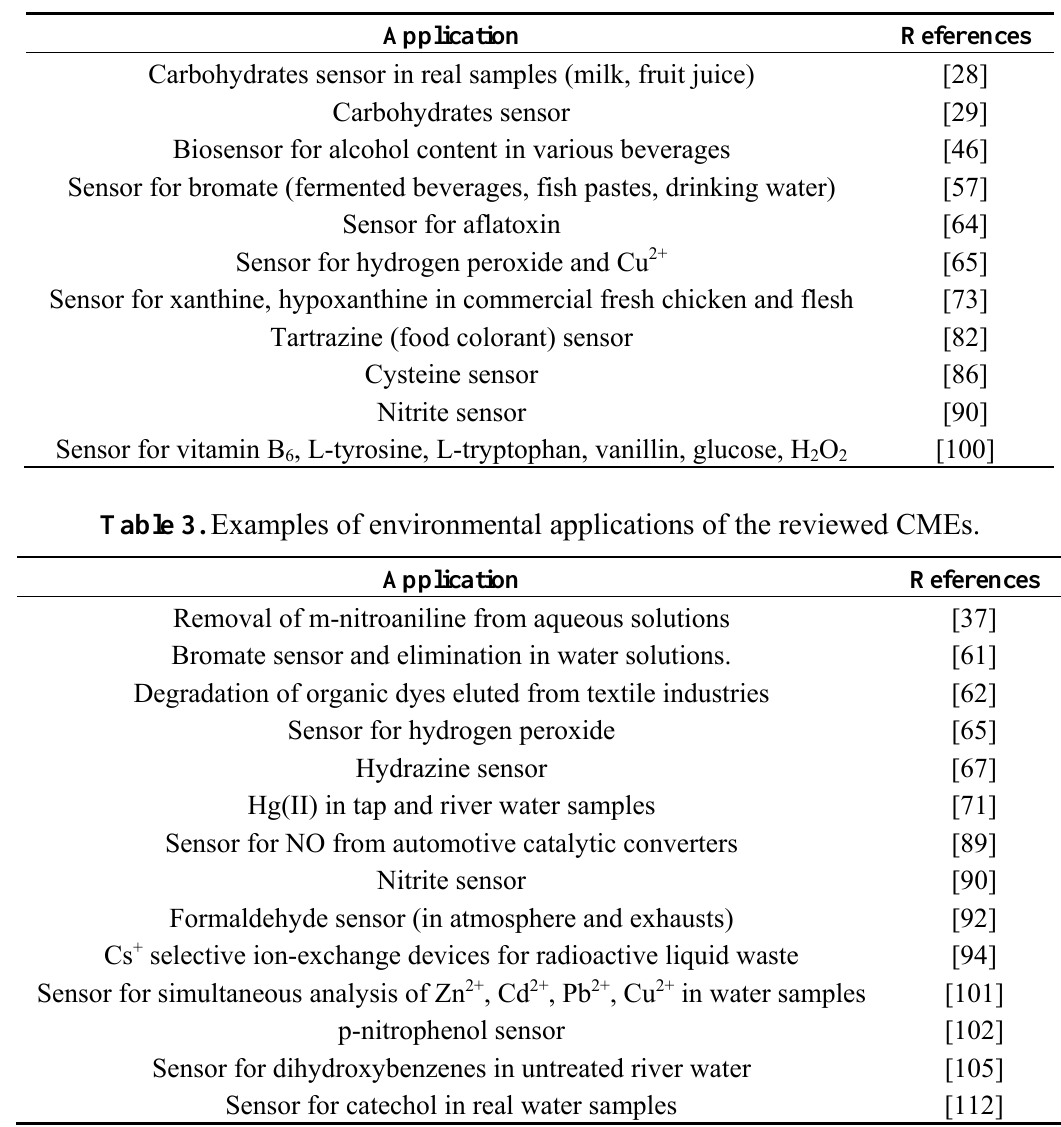
Table 2. Examples of applications of the reviewed chemically modified electrodes (CMEs) in food analysis.